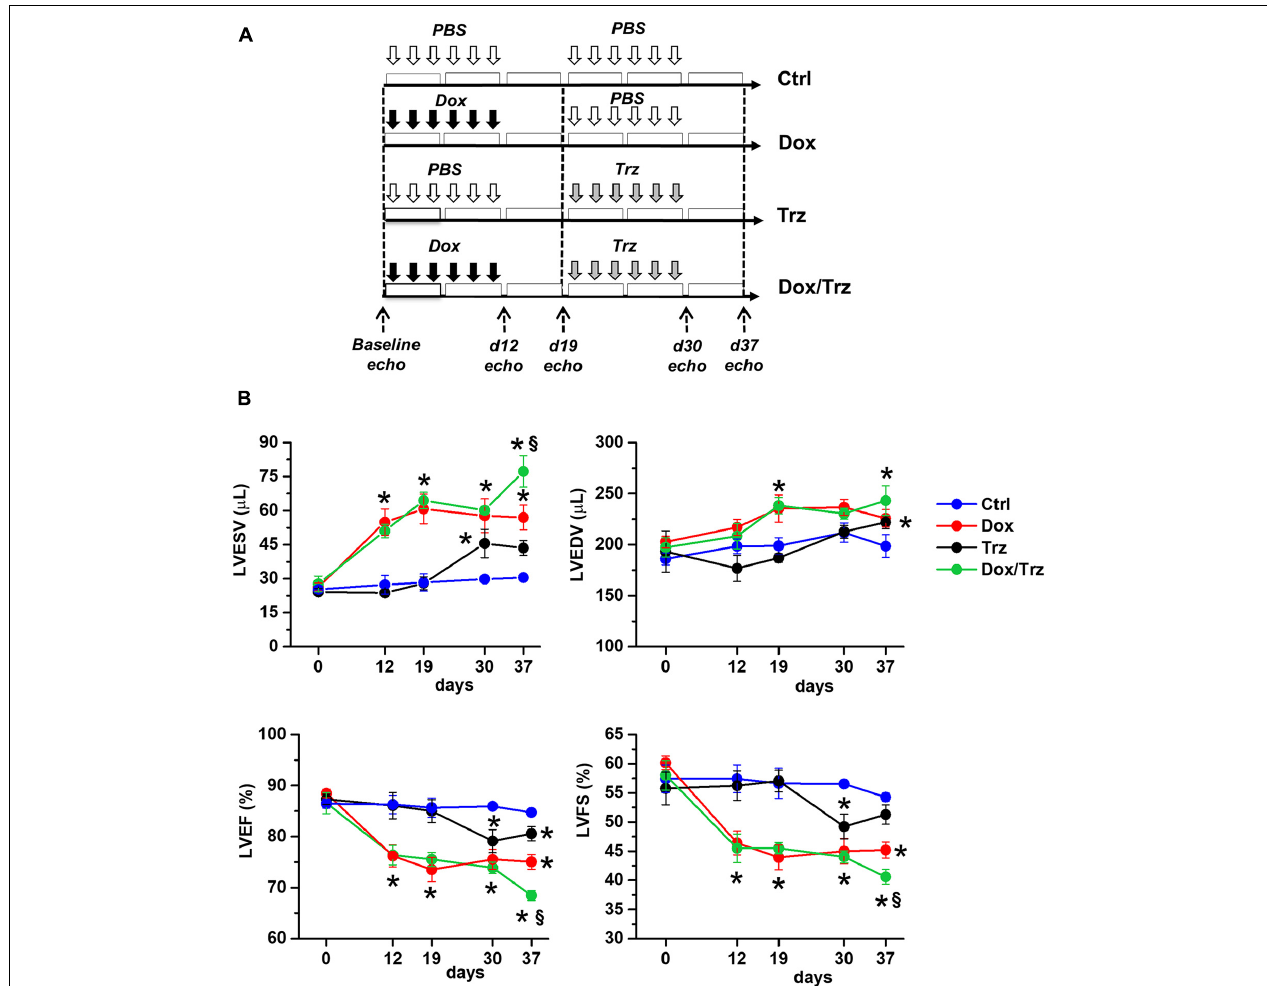
FIGURE 1 | Effects of Dox and Trz on LV function. (A) Schema depicting the experimental protocol. Dox and Trz were administered sequentially (from d1 to d11, and from d19 to d29, respectively). The timing of Trz administration was the same in the Dox/Trz and Trz groups. (B) Echocardiographic results for LV end-systolic volume (LVESV), LV end-diastolic volume (LVEDV), LV ejection fraction (LVEF), and LV fractional shortening (LVFS) in different groups at varying time points. Two-way ANOVA for multiple groups has been used. Data are mean ± SEM; * p < 0.05 vs. Ctrl; § p < 0.05 vs. Trz (Ctrl, n = 5; Dox, n = 6; Trz, n = 8; Dox/Trz, n = 6). Additional data generated at later time points after Trz administration are shown in Supplementary Figure 1